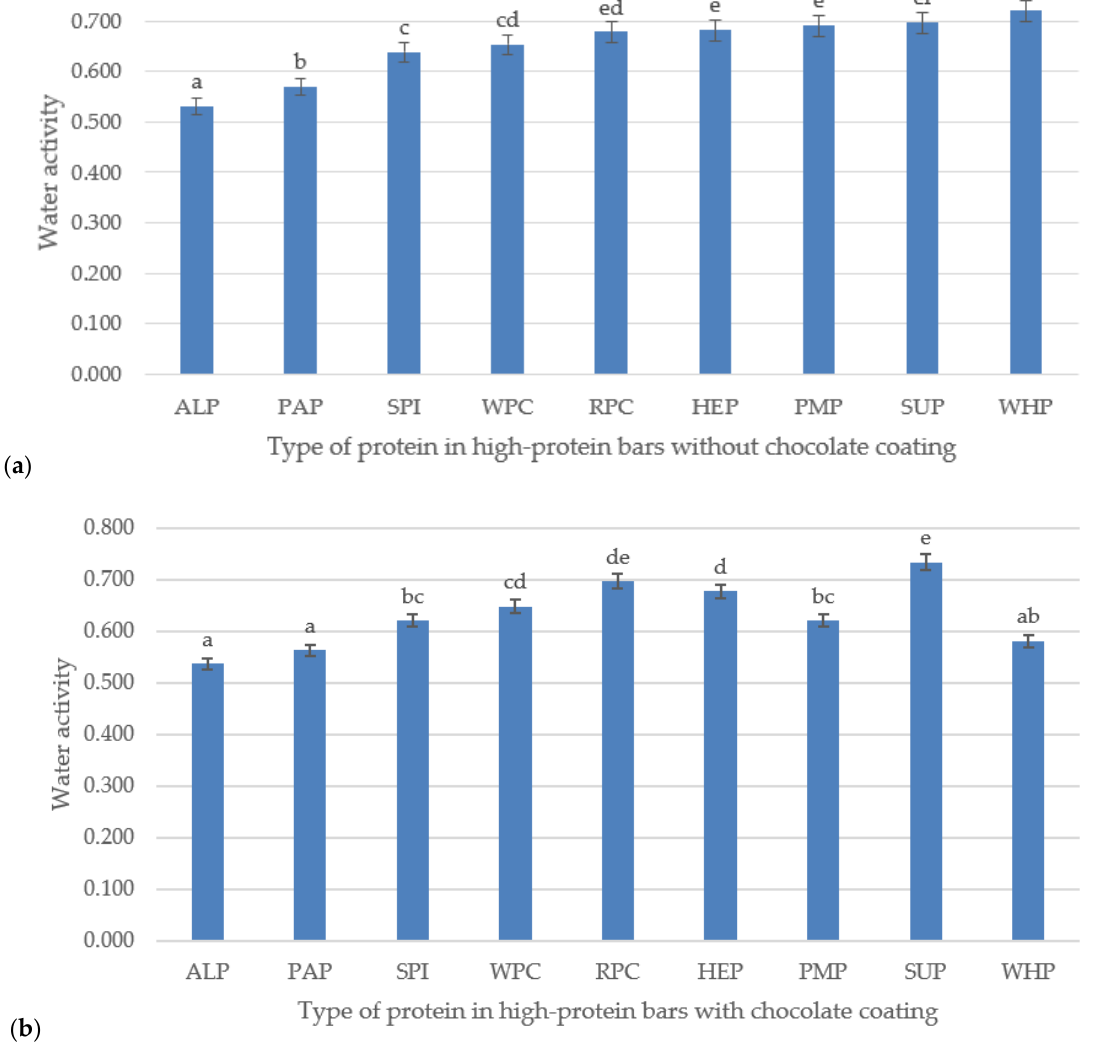
Figure 2. ( a ) Effect of different protein application on water activity of high-protein bars without chocolate coating; ( b ) With chocolate coating. Letters (a–f) indicate significant differences at p < 0.05 (Tukey’s HSD test).